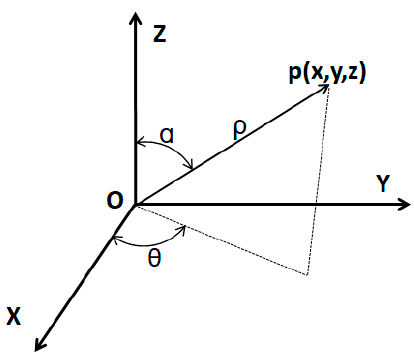
Figure 3. Relation between rectangular and polar coordinates.